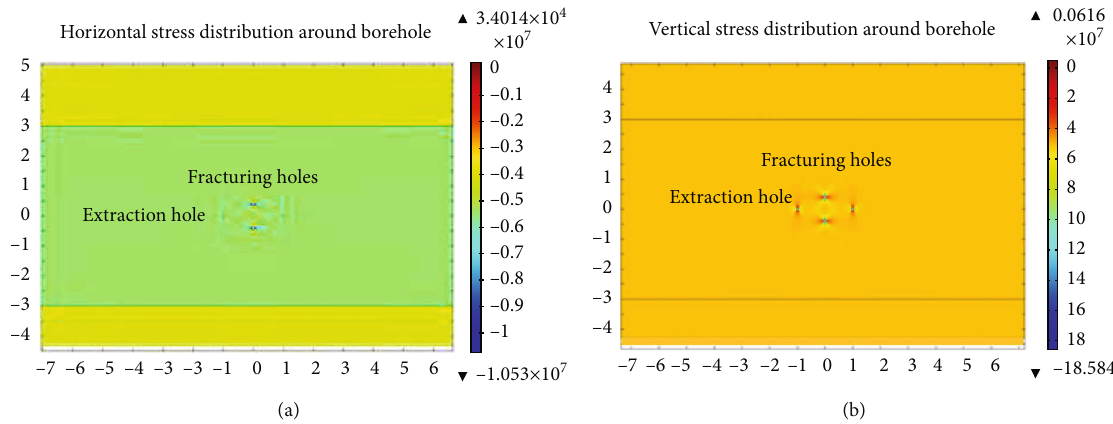
Figure 16: The stress distribution around the boreholes of mesh hole fracturing.